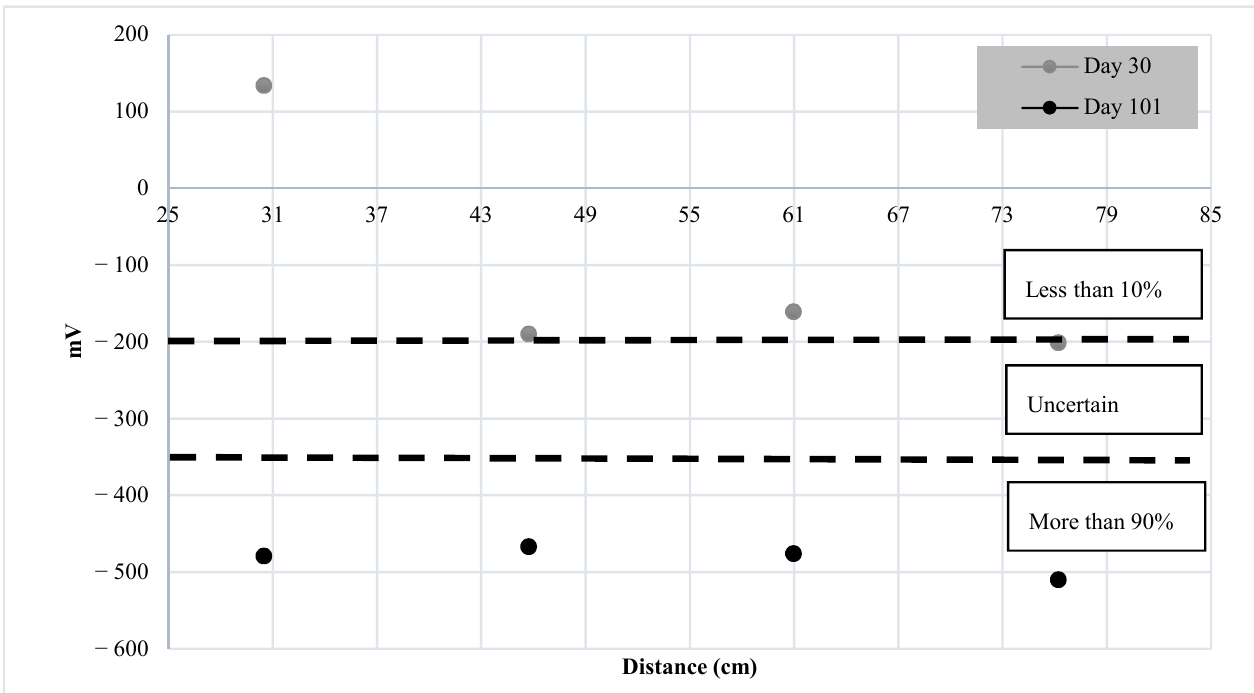
Figure 12. HCP measurements for Specimen B.